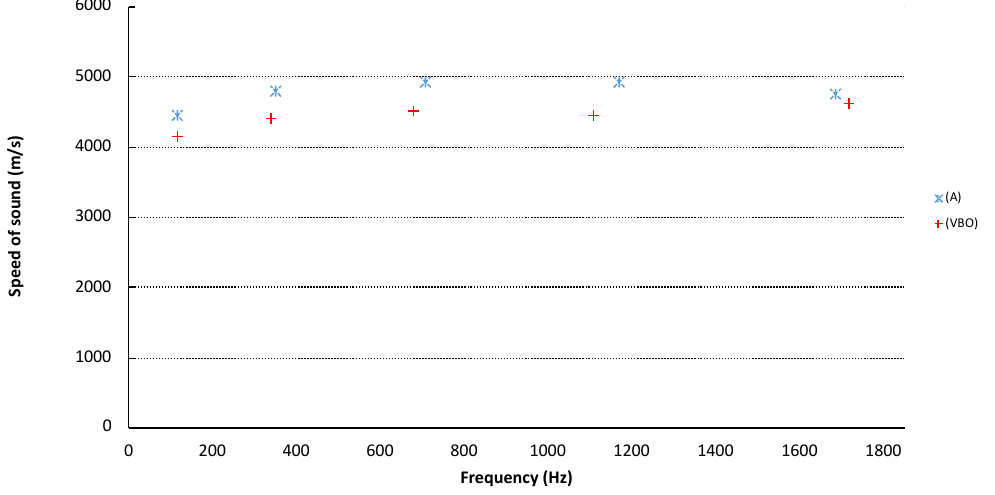
Figure 10. Average sound speed ( c ) at different frequencies, for CFRE prepregs, processed by A (autoclave) and VBO (vacuum bag-only).